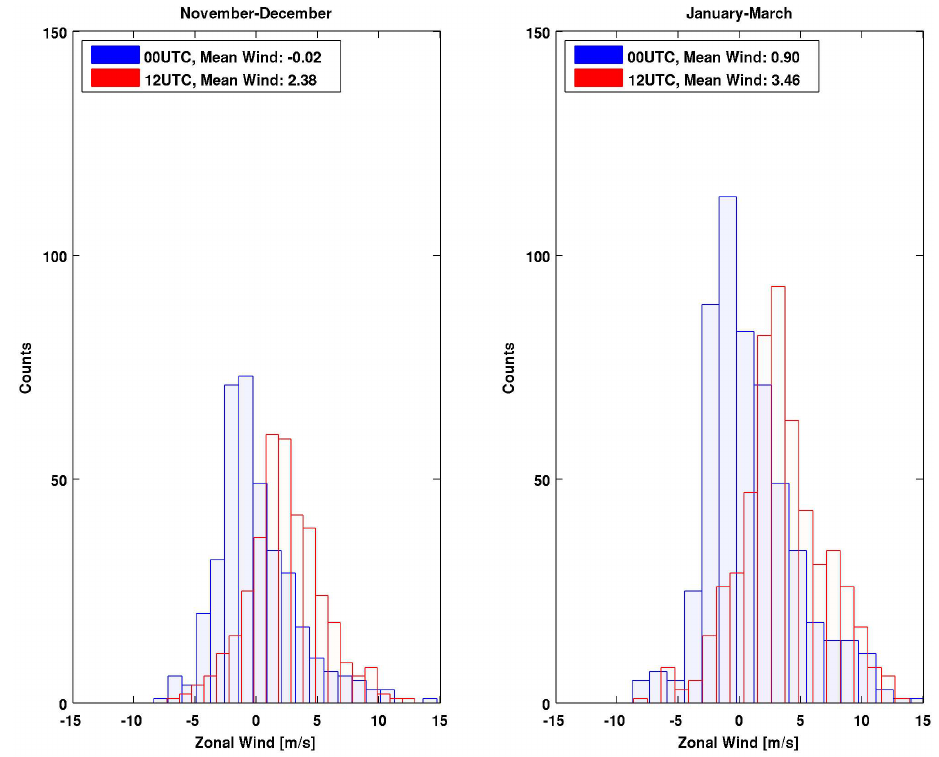
Fig. 5. Histograms of low-level zonal winds on rain days measured by Beit-Dagan (Israeli Meterological Service) radiosondes, left fig- ure corresponds to November–December months, and right figure to January–March. Nighttime (00:00UTC, blue color) and afternoon (12:00UTC, red color) soundings are superimposed. The average zonal wind speed between 1000hPa ( ∼ 50m) and 940hPa ( ∼ 600m) was taken as a characteristic value for the low-level boundary layer